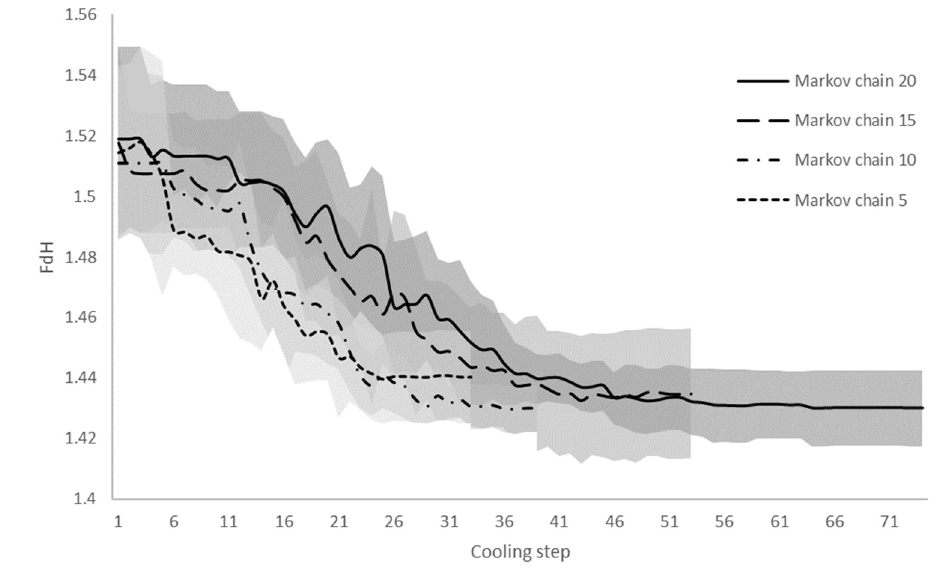
Figure 2. FdH versus cooling step using 49 parallel groups.